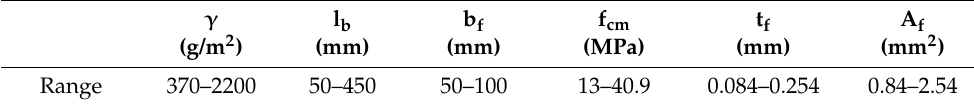
Table 5. Range of variability for the collected data of bond tests.